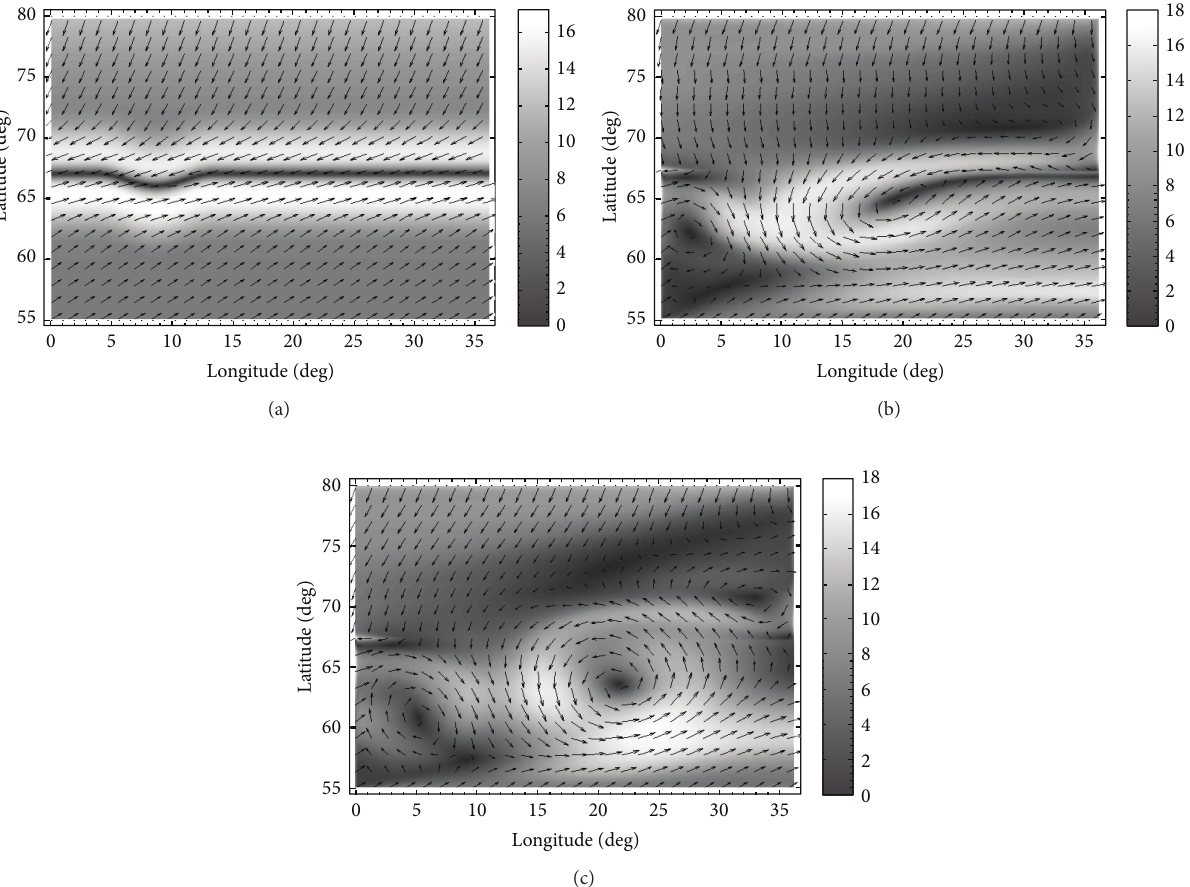
Figure 2: The same as in Figure 1, but obtained for the second case when, at the initial moment, the modules of the zonal wind velocities at more northern latitudes relatively to the centerline of the arctic front are less than those at more southern latitudes relatively to it. The degree of shadowing of the figures indicates the module of the velocity in